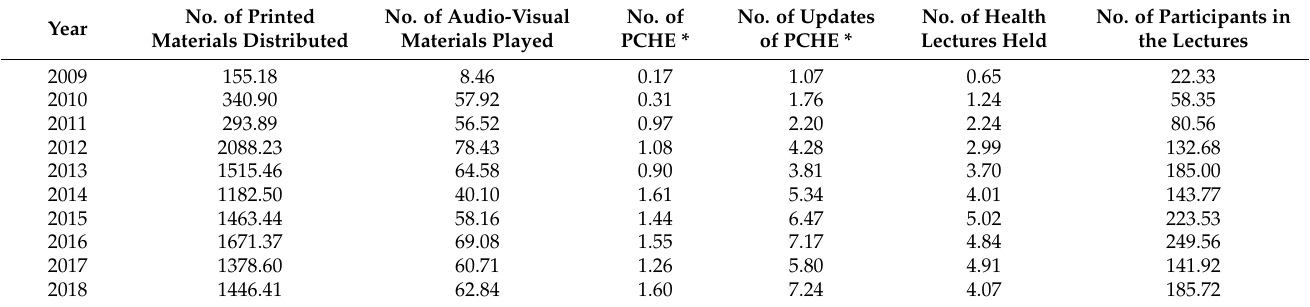
Table 1. Health education for residents in Inner Mongolia from 2009 to 2018 (shown in ten thousands).